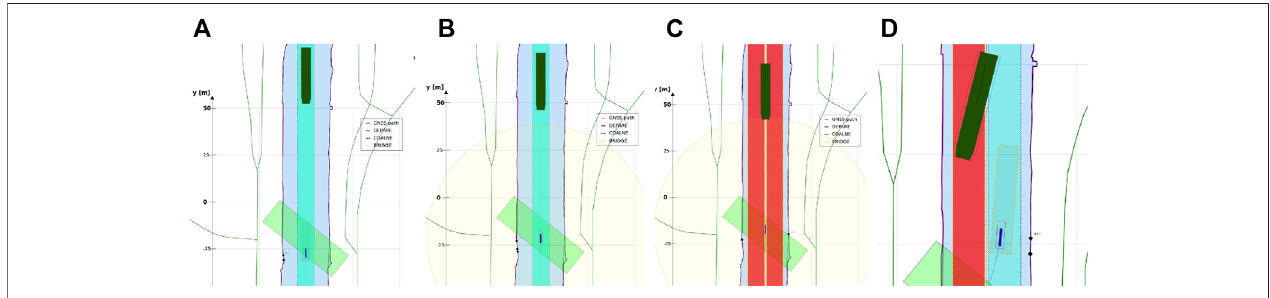
FIGURE 13 | Lane shift primitive, triggered by geometry – perception relation (exteroceptive sensor subsystem), i.e., an approaching vessel detected by exteroceptive sensor(s), within prede fi ned range. Lanes with vessel inside is shown in transparent green; lanes with vessels outside are shown in red.